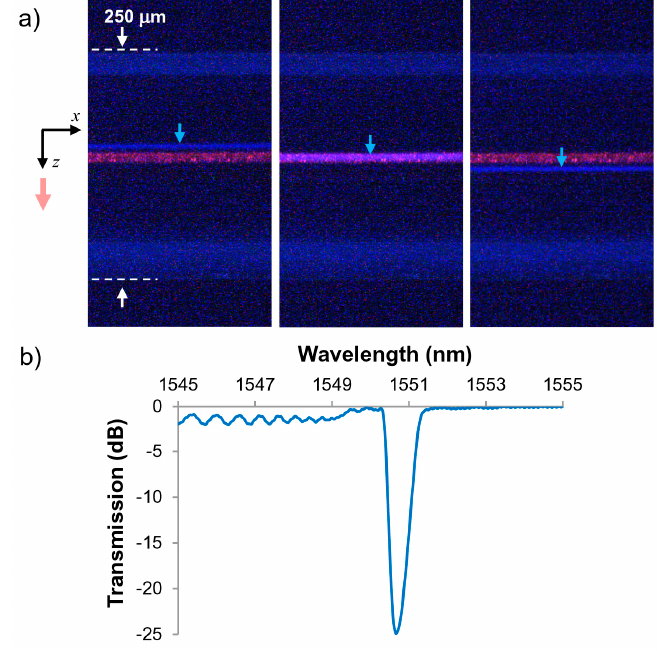
Figure 16. ( a ) Femtosecond laser focus alignment through an acrylate-coated SMF-28 fiber as facilitated by nonlinear and dark-field microscopy [121]. The fiber core is imaged by Rayleigh scattering of coupled red λ 2 = 637 nm light. The left-hand image shows blue photoluminescence in front of the core, the middle image the increased photoluminescence as the line focus overlaps the core, and the right-hand image the photoluminescence of the laser line focus beyond the core. ( b ) The transmission spectrum of a TTC FBG written with the photoluminescence line focus aligned on the core (middle image Figure 16a).